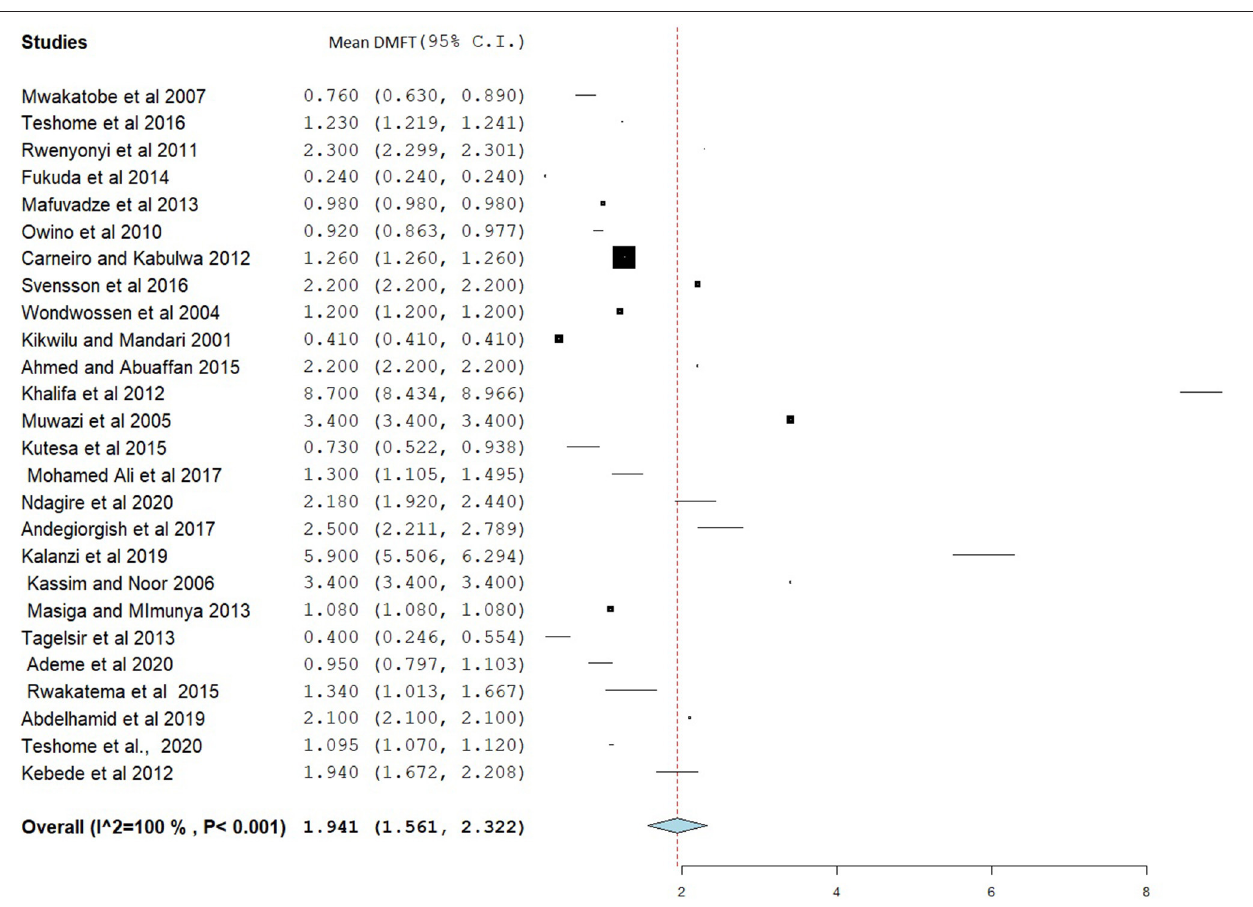
FIGURE 7 | Forest plot showing the mean DMFT in East